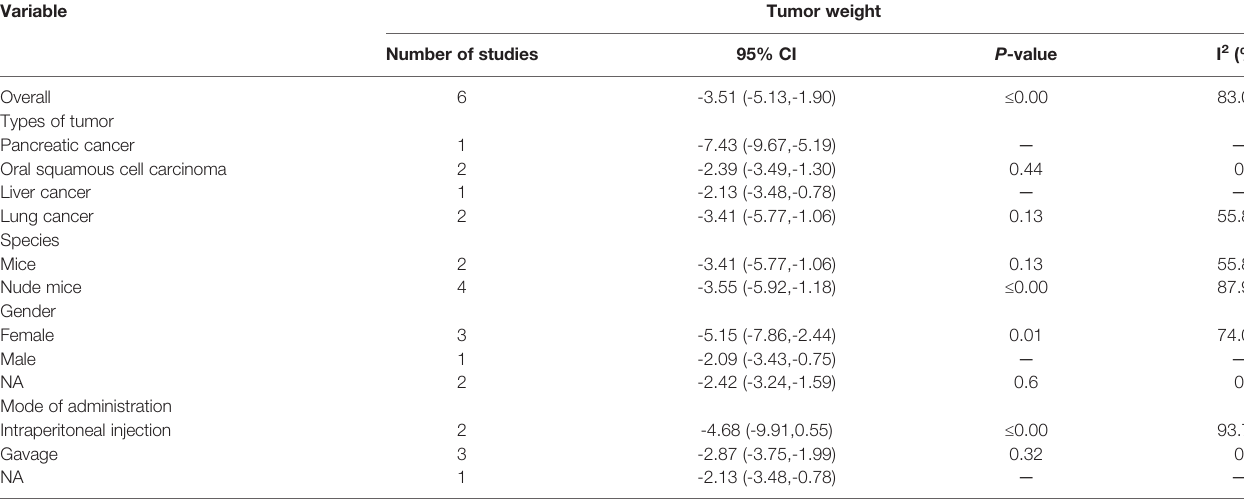
TABLE 3 | Sub-analysis of the effects of EVO on tumor